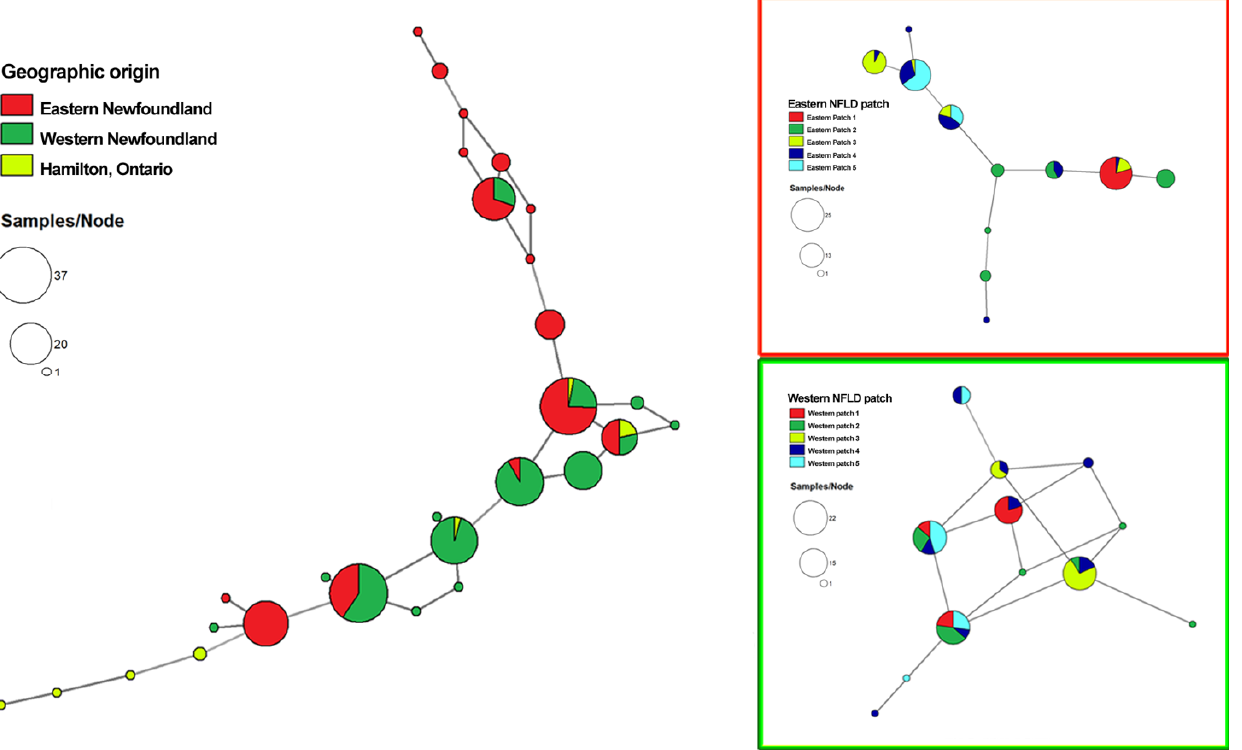
Figure 2. Minimum-spanning network for C. enelensis showing the genetic relationship between MLGs. Each circle represents one MLG, where node size corresponds to the number of fruiting bodies for each MLG. The genetic distance between MLGs was calculated using Bruvo’s genetic distance. The MSN for the relationship between all the MLGs from eastern and western NFLD and the mainland (ON) is displayed on the left, whereas the two MSN trees on the right are for the eastern and western NFLD regions.